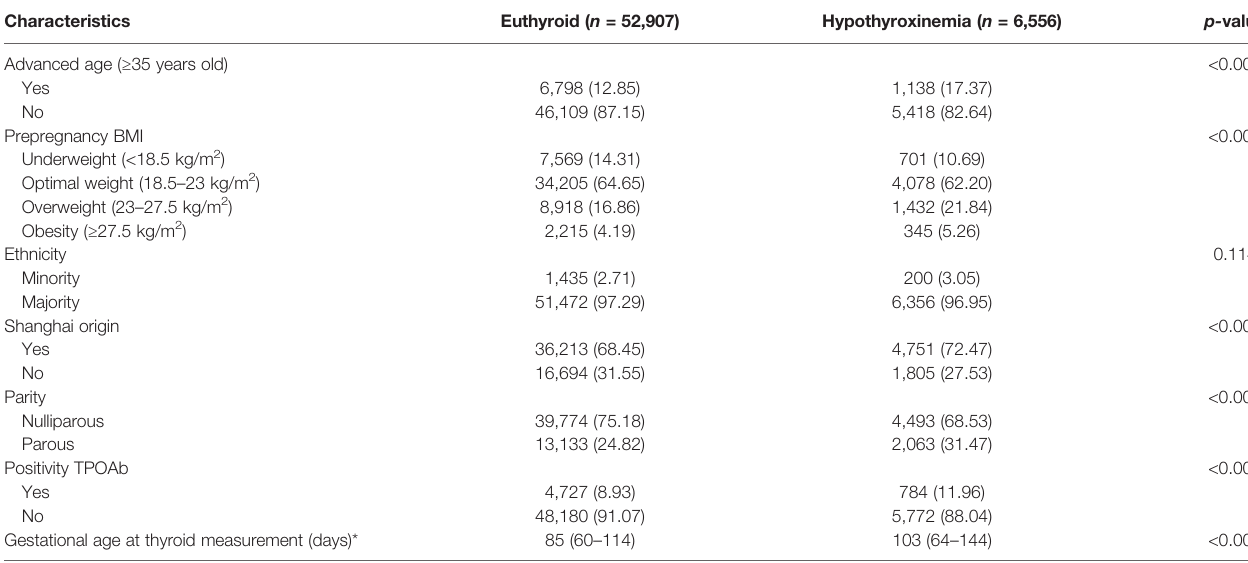
TABLE 1 | The characteristics of the study population.